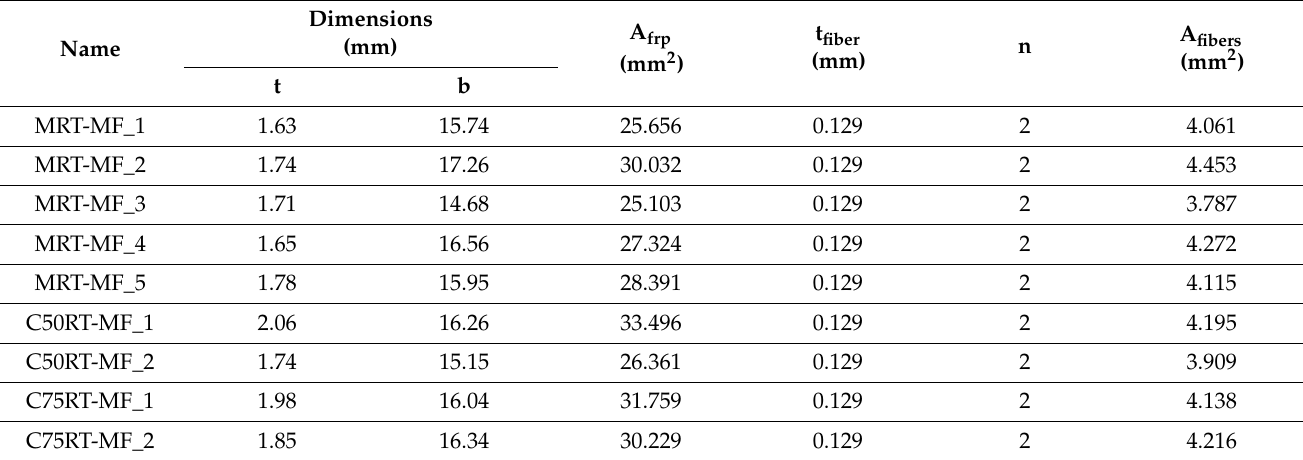
Table 2. Characteristics of specimens of experiments under room